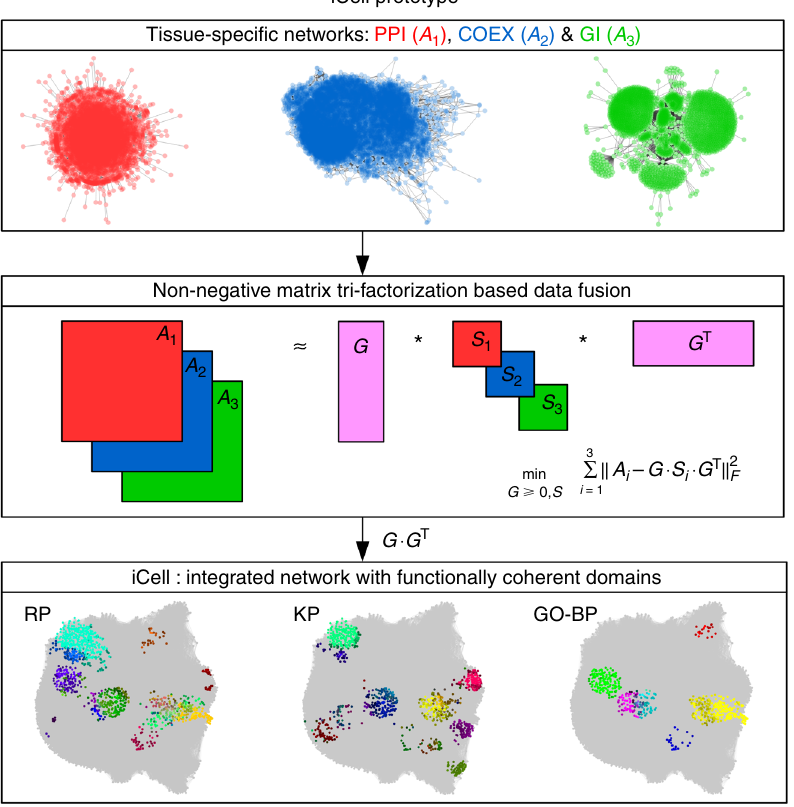
Fig. 1 Illustration of iCell. Each iCell is based on three tissue-speci fi c molecular networks: protein – protein interaction network (PPI, in red), gene co- expression network (COEX, in blue), and genetic interaction network (GI, in green). These networks, represented by their adjacency matrices, A i , are simultaneously decomposed as the product of three factors, G , S i , and G T , as detailed in Methods (illustrated in the middle panel). From these matrix factors, we extract an integrated network, which we call an iCell. For illustration purposes, we used spatial analysis of functional enrichment (SAFE) 53 on the iCell of breast control tissue to highlight regions of iCells that are enriched in reactome pathway (RP), KEGG pathway (KP), or gene ontology biological process (GO-BP) annotations (bottom). In these plots, genes from the same functional domain have the same color (see